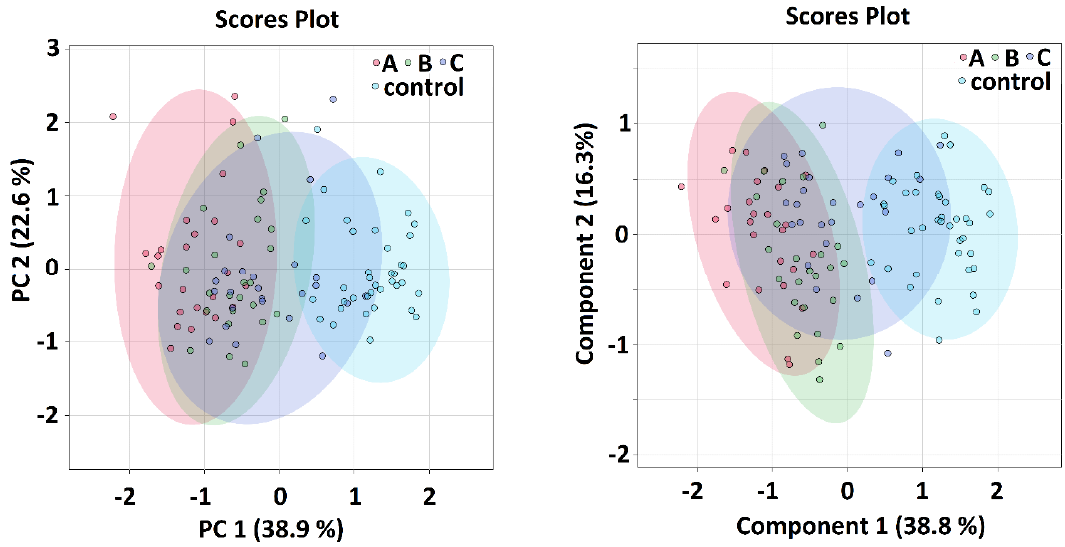
Figure 1. PCA ( left ) and PLS–DA ( right ) analysis of patients with COVID–19 disease at three various sampling times in patients and controls, the relative concentrations of metabolites in blood plasma were used as input